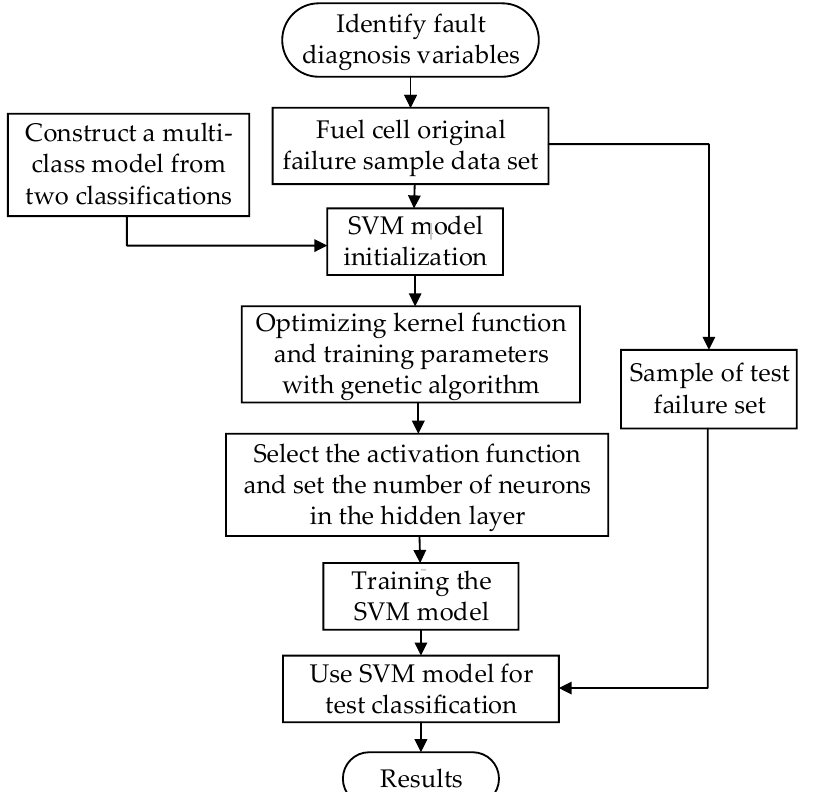
Figure 8. Flow diagram of the GA-SVM diagnosis process.